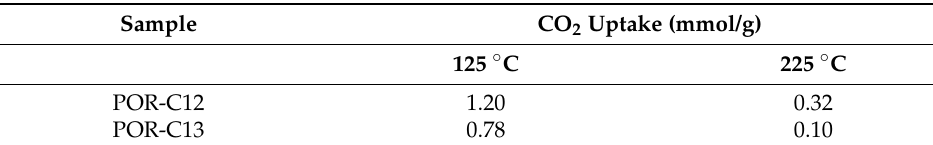
Table 5. CO 2 uptake results of the samples tested at 125 ◦ C and 225 ◦ C.